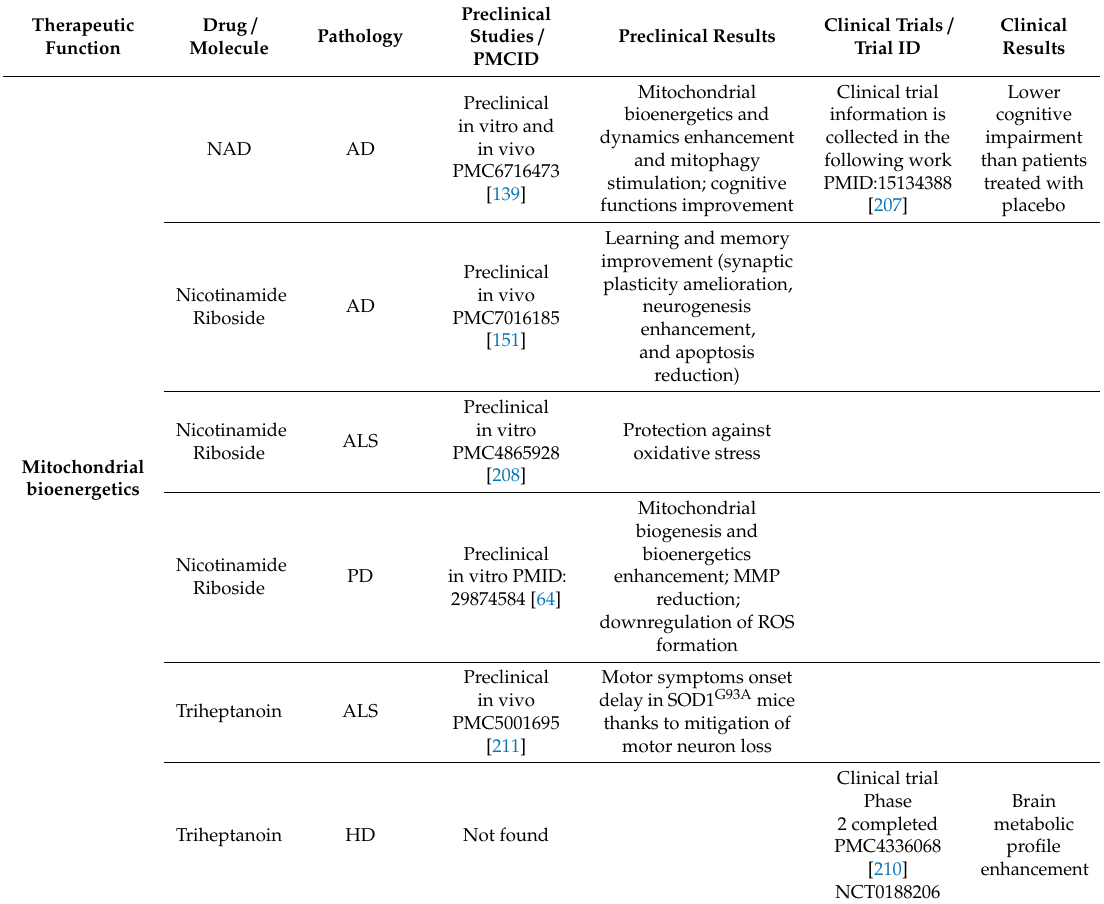
Table 4. Compounds acting on mitochondrial bioenergetics. The table lists compounds involved in mitochondrial bioenergetics enhancement, providing an overview of preclinical and clinical studies. For clinical trial ID we referred to https: //